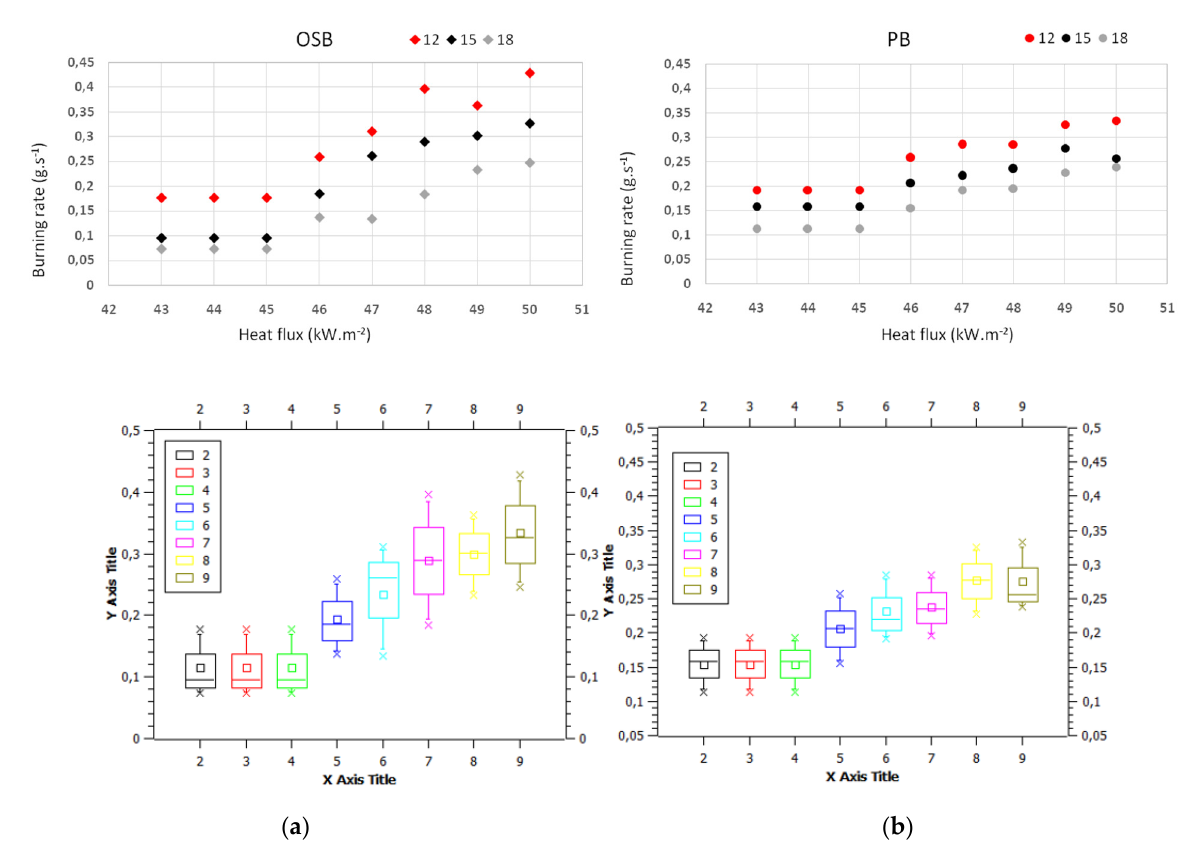
Figure 7. Graphical dependence of burning rate of OSB and PB samples depending on thermal stress. Legend: 12, 15, 18 are values of thickness. Box plots, have X Axis marks as 2—43 kW.m − 2 ; 3—44 kW.m − 2 ; 4—45 kW.m − 2 ; 5—46 kW.m − 2 ; 6—47 kW.m − 2 ; 7—48 kW.m − 2 ; 8—49 kW.m − 2 ; and 9—50 kW.m − 2 . Confidential interval 95%.